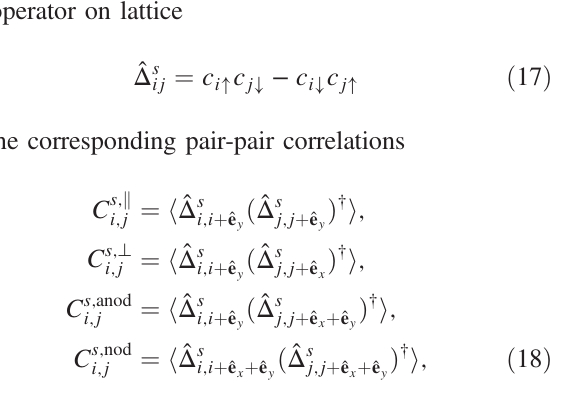
FIG. 4. Pair-pair correlation in j Ψ − i 2 with the pairing orientations indicated in the inset: (a) and (b) show the correlations between the h and C s; ⊥ , respectively; (c) shows the NNN hole pair correlation C s; nod NN hole pairs at two perpendicular directions, C s; k i;j i;j (d) shows the correlation between the NN and NNN hole pairing, C s; anod . The starting point i is chosen at i i;j i x; j i . Note that the variational parameter g − ð i; j Þ fitted in Eq. (19) with j g − ð i; j Þj set as 1 is used in the ending point at j x ¼ x þ y ¼ y calculation of the correlators at a large lattice size 64 × 64